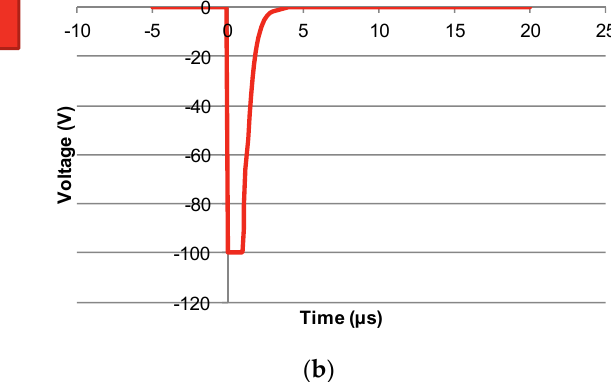
Figure 7. ( a ) Measurement set ‐ up for pulse ‐ echo measurement; ( b ) Drive pulse used.